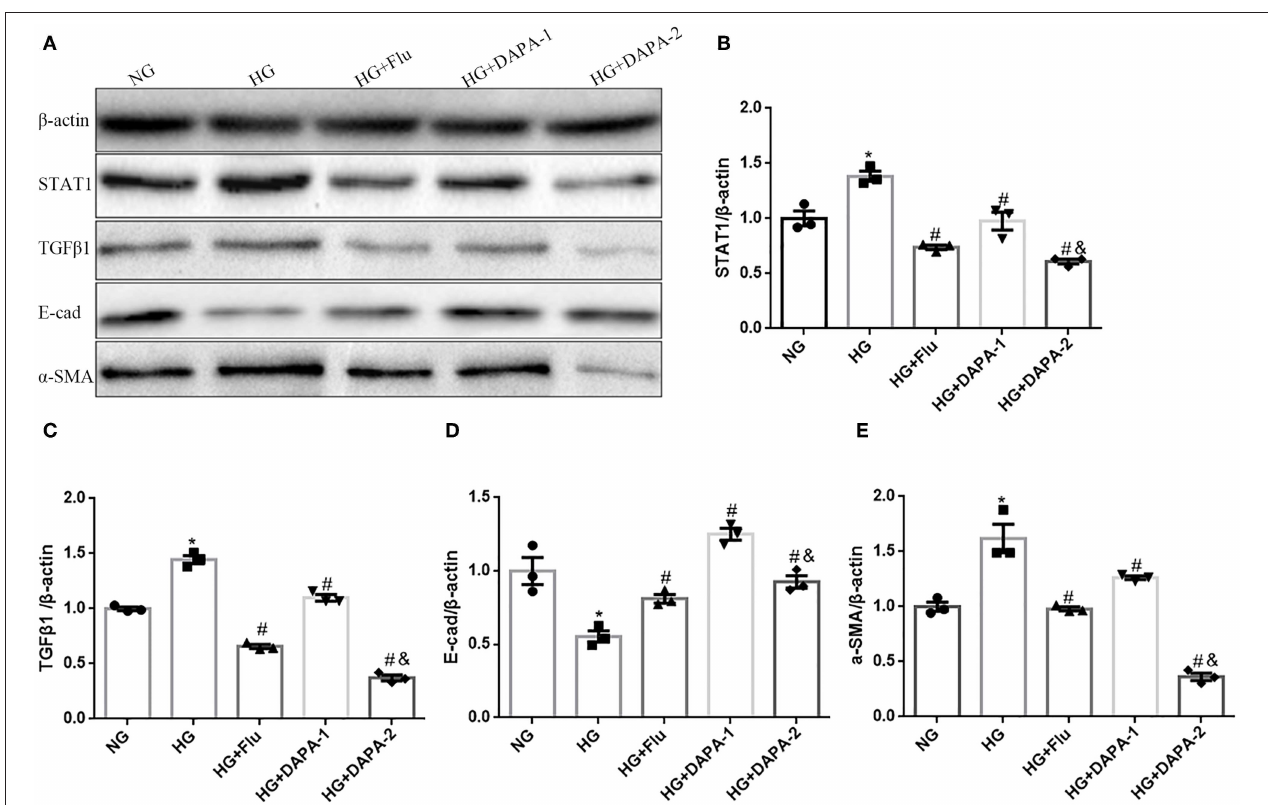
FIGURE 7 | Effects of DAPA and Flu on the expression of EMT-related proteins in HK-2 cells. (A) Representative western blots illustrating STAT1, TGF- β 1, E-cadherin, α -SMA, and β -actin protein expression in HK2 cells. (B–E) Quantification of the western blot data in HK-2 cells. Statistical analysis was performed with one-way ANOVA. Results are expressed as the mean ± SEM. * P < 0.05 vs. NC, # P < 0.05 vs. HG, # & P < 0.05 vs. HG +